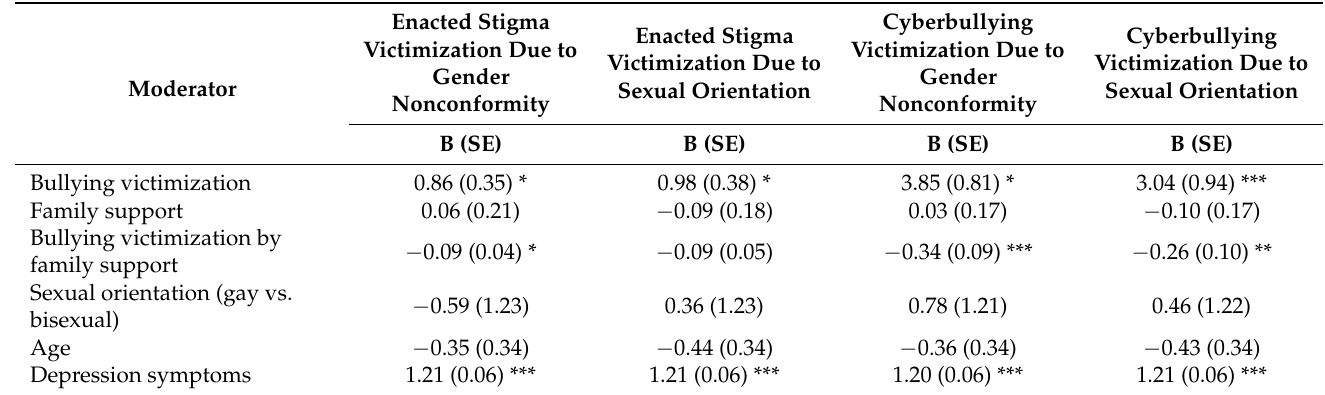
Figure 2. Visualization of the mediation models of Depression Symptoms on Relationship between Bullying Victimization and Borderline Personality Disorder Symptoms. Results are shown as the regression coefficient and 95% bootstrap confidence interval. These mediation analyses were conducted after adjustment for family support, age and sexual orientation for mediator and outcome variables. Table 3. Moderation of Family Support in Association between Bullying Victimization and Borderline Personality Disorder